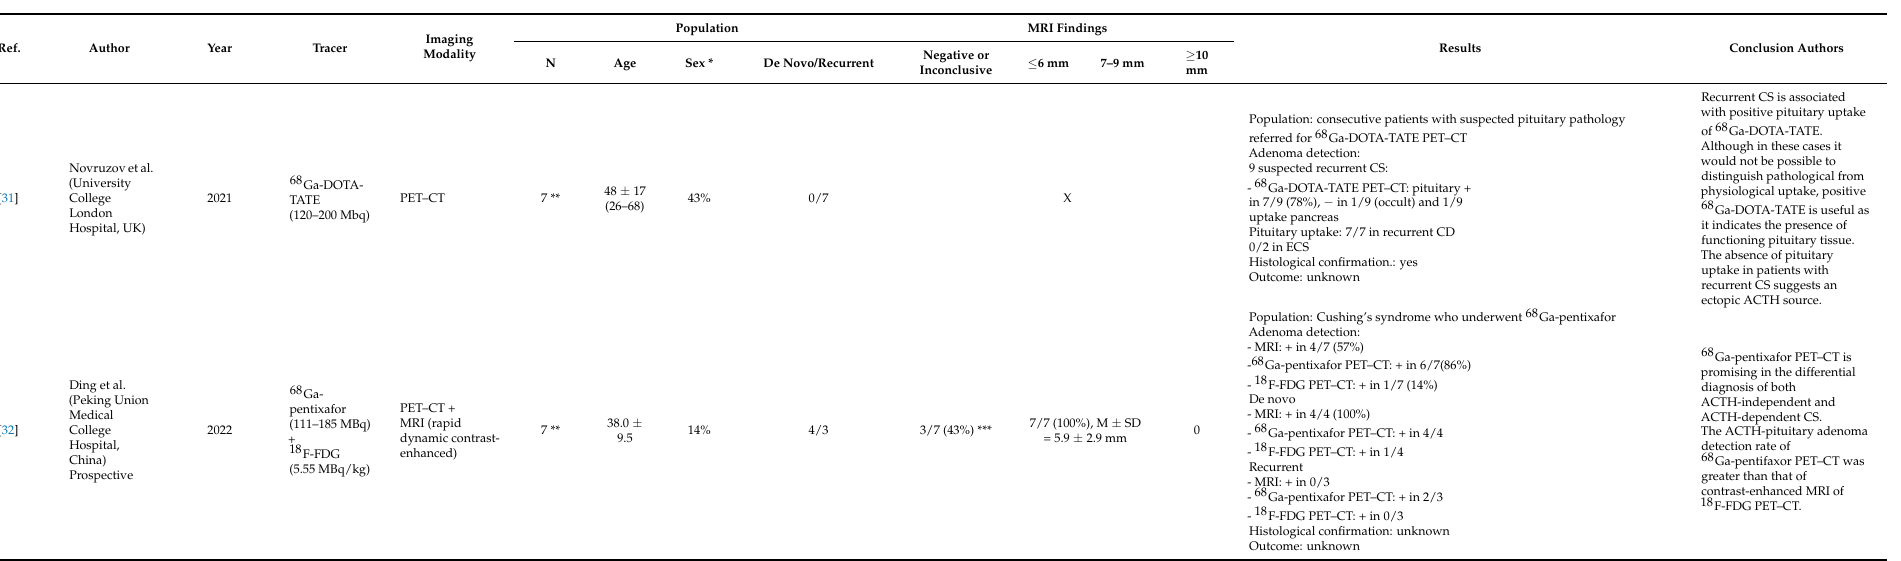
RecurrentCSisassociated withpositivepituitaryuptake of68Ga-DOTA-TATE. Althoughinthesecasesit wouldnotbepossibleto